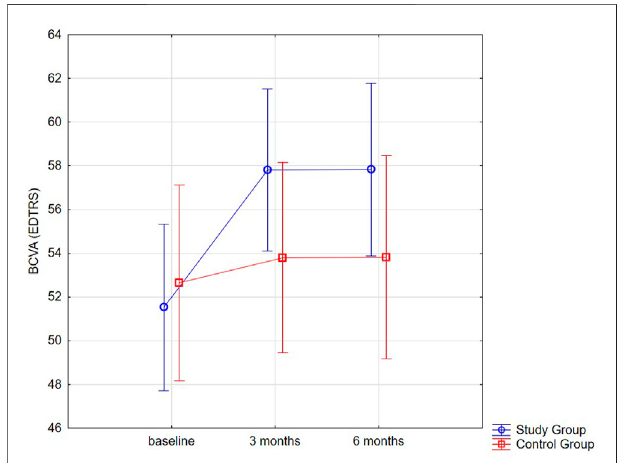
FIGURE 1 | Distribution plot for BCVA (EDTRS letters) mean values in both groups at baseline and 3 and 6